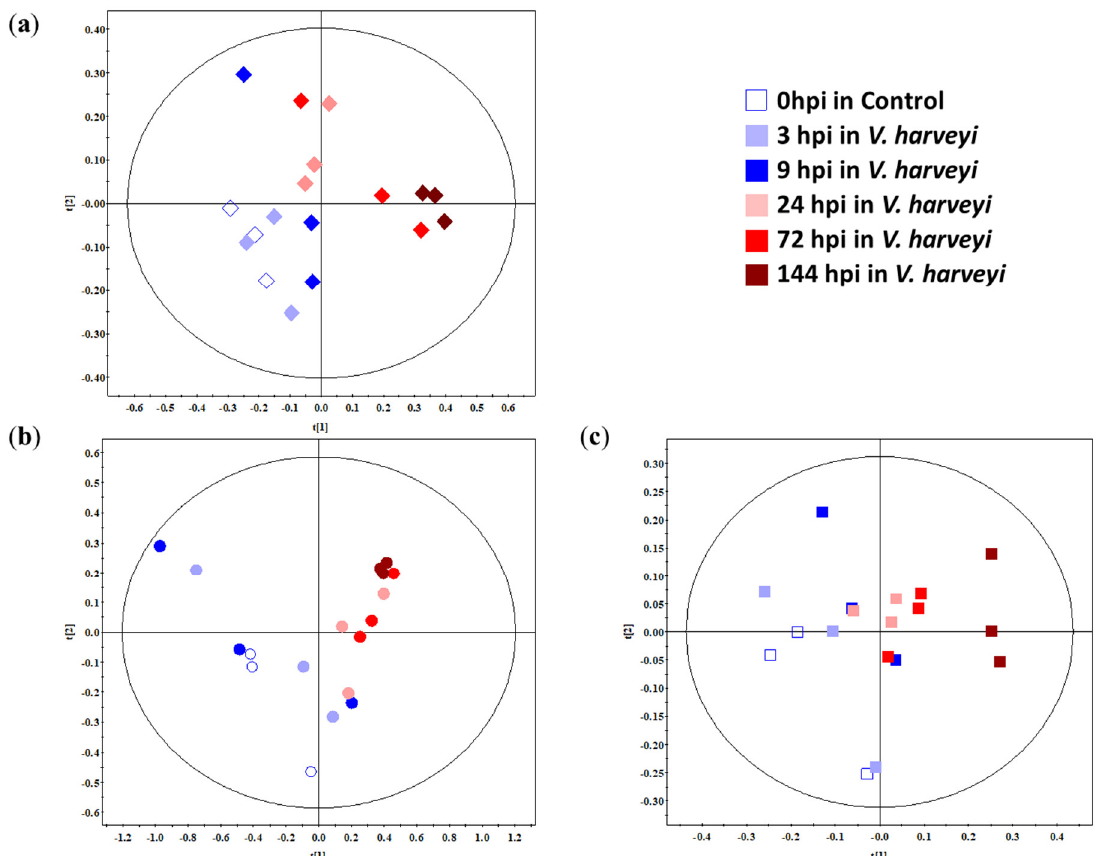
Figure 2. Partial Least Square (PLS) score plots based on the Nuclear Magnetic Resonance (NMR) spectra of the ( a ) gills ( ◇ , diamond), ( b ) hepatopancreas ( ○ , circle), and ( c ) haemolymph (□, square) from the whiteleg shrimp ( Litopenaeus vannamei ) infected with Vibrio harveyi . The shapes in diamond, circle and square represent samples in gills, hepatopancreas and haemolymph, respectively. The classification parameters for the PLS score plot were as follows: R 2 X = 0.987, R 2 Y = 1 and Q 2 = 1, R 2 X = 0.986, R 2 Y = 1 and Q 2 = 1 and R 2 X = 0.982, R 2 Y = 1 and Q 2 = 1 for the gills, hepatopancreas and haemolymph, respectively. The colour represents hours post injection to V. harveyi in shrimp. □, 0 hpi in the control group; ■ , 3 hpi; ■ , 9 hpi; ■ , 24 hpi; ■ , 72 hpi; ■ , 144 hpi in the V. harveyi infected group.